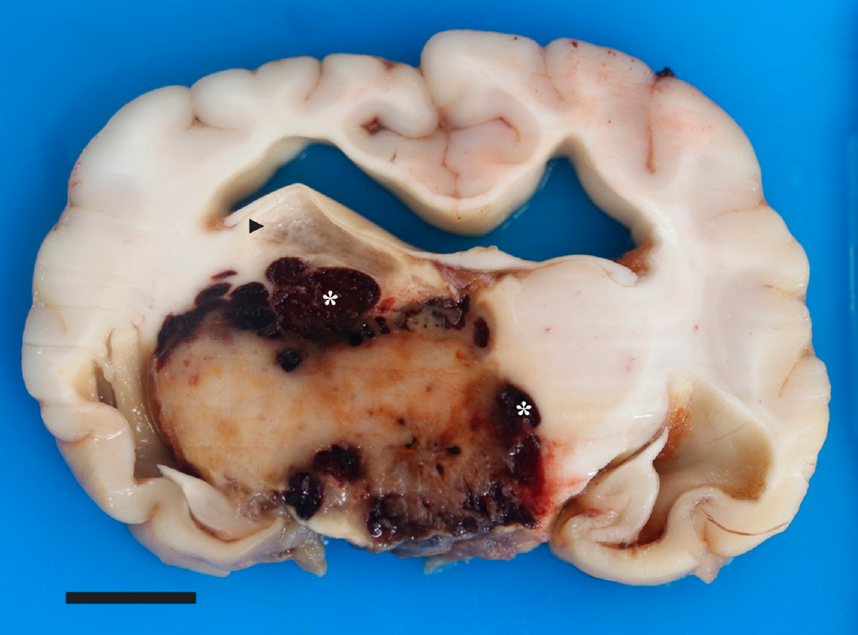
Figure 3. Pilocytic astrocytoma in a young dog’s brain. Macroscopic picture of cut surface of the brain at the level of the thalamus, depicting a well-circumscribed, 2.6 cm × 1.8 cm, expansile, tan/brown mass bordered by coalescing pockets of hemorrhage (asterisks). There is separation of the right fornix and stria habenularis from the dorsal aspect of the mass by a region of malacia (arrowhead). Moderate dilation of the lateral ventricles is depicted. Bar is 1 cm.